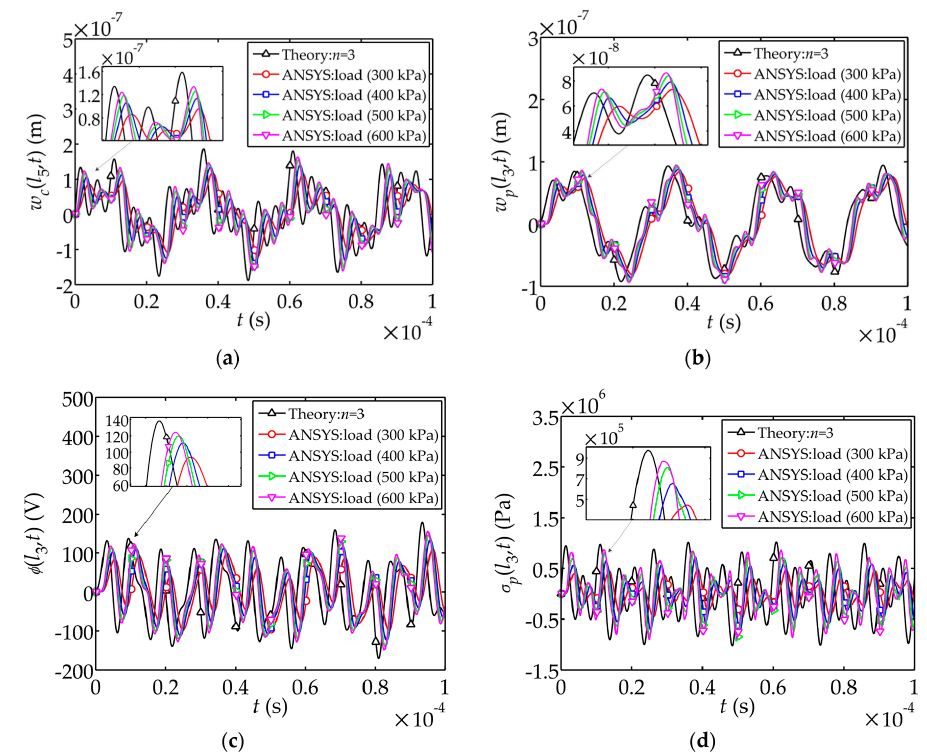
Figure 4. Comparisons of theoretical solutions and the numerical solutions of displacement, electric potential and stress: ( a ) Displacement w c ( l 5 , t ); ( b ) Displacement w p ( l 3 , t ); ( c ) Electric potential ϕ ( l 3 , t ); ( d ) Stress (cid:2026) (cid:3043) ( l 3 , t ).